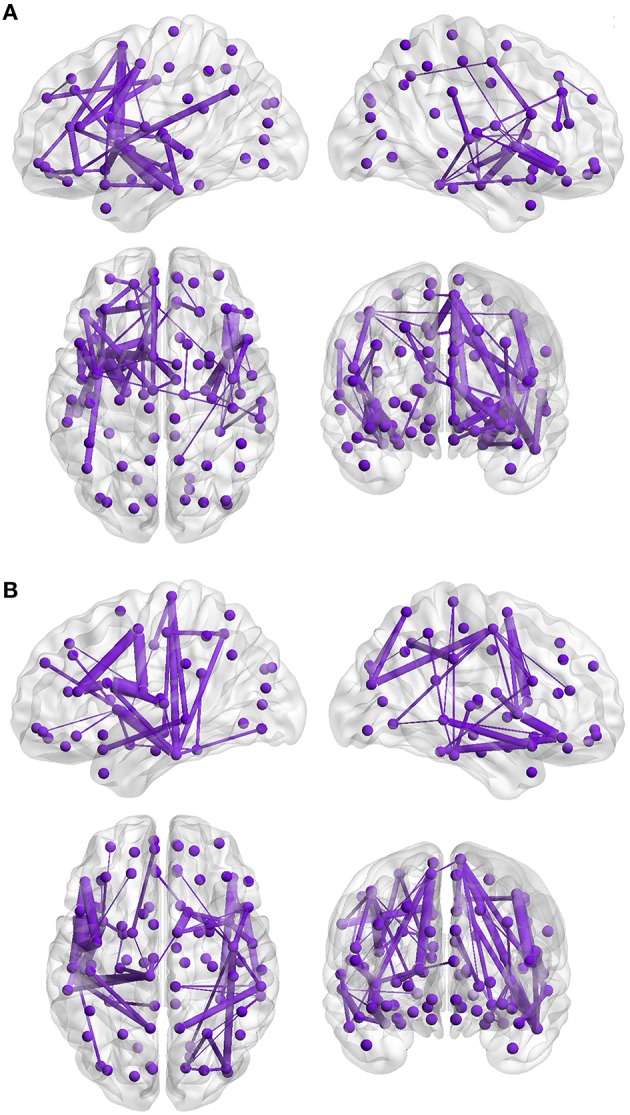
Inverse correlation between structural connectivity and Rivermead Post-Concussion Symptoms Questionnaire scores of the patients and group comparison. The 3D visualization of the network (Xia et al., 2013) shows a lateral section of the left and the right hemispheres (upper panels), horizontal and coronal sections (lower left: superior perspective, lower right: anterior perspective). The violet-colored dots correspond to the 90 cortical and sub-cortical automated anatomical labeling regions. The violet lines represent the supra-threshold connections of the subnetwork. The thickness of the lines represents the absolute connectivity strength of each connection. (A) The connectivity strength of one subnetwork is inversely correlated with the total RPQ score of the patients (n = 51, mean r = −0.31, p = 0.045 corrected). (B) Reduced structural connectivity in the subgroup of 30 mTBI patients compared to 30 matched controls (Cohen's d = 0.95, p = 0.027).